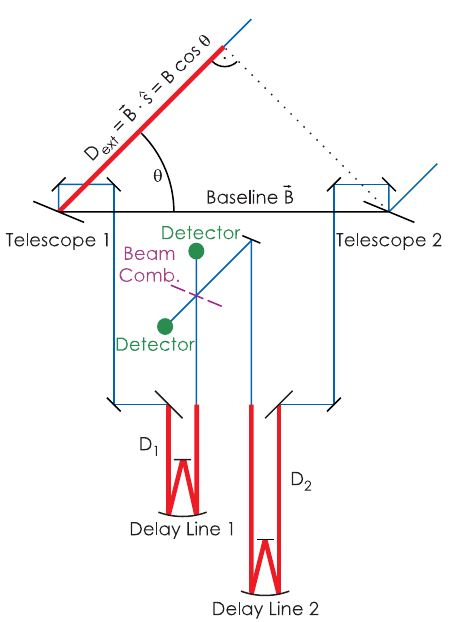
Figure 1. Schematic drawing of the light path through a two-element interferometer. The beam combiner is a 50% transmissive mirror. The external delay D = (cid:3) B · ˆ s is compensated by the two delay lines. The pathlengths D 1 , D 2 through the delay lines are monitored with internal laser interferometers. The zero-order interference maximum occurs when the delay line positions are such that the internal delay D int = D 2 − D 1 is equal to D